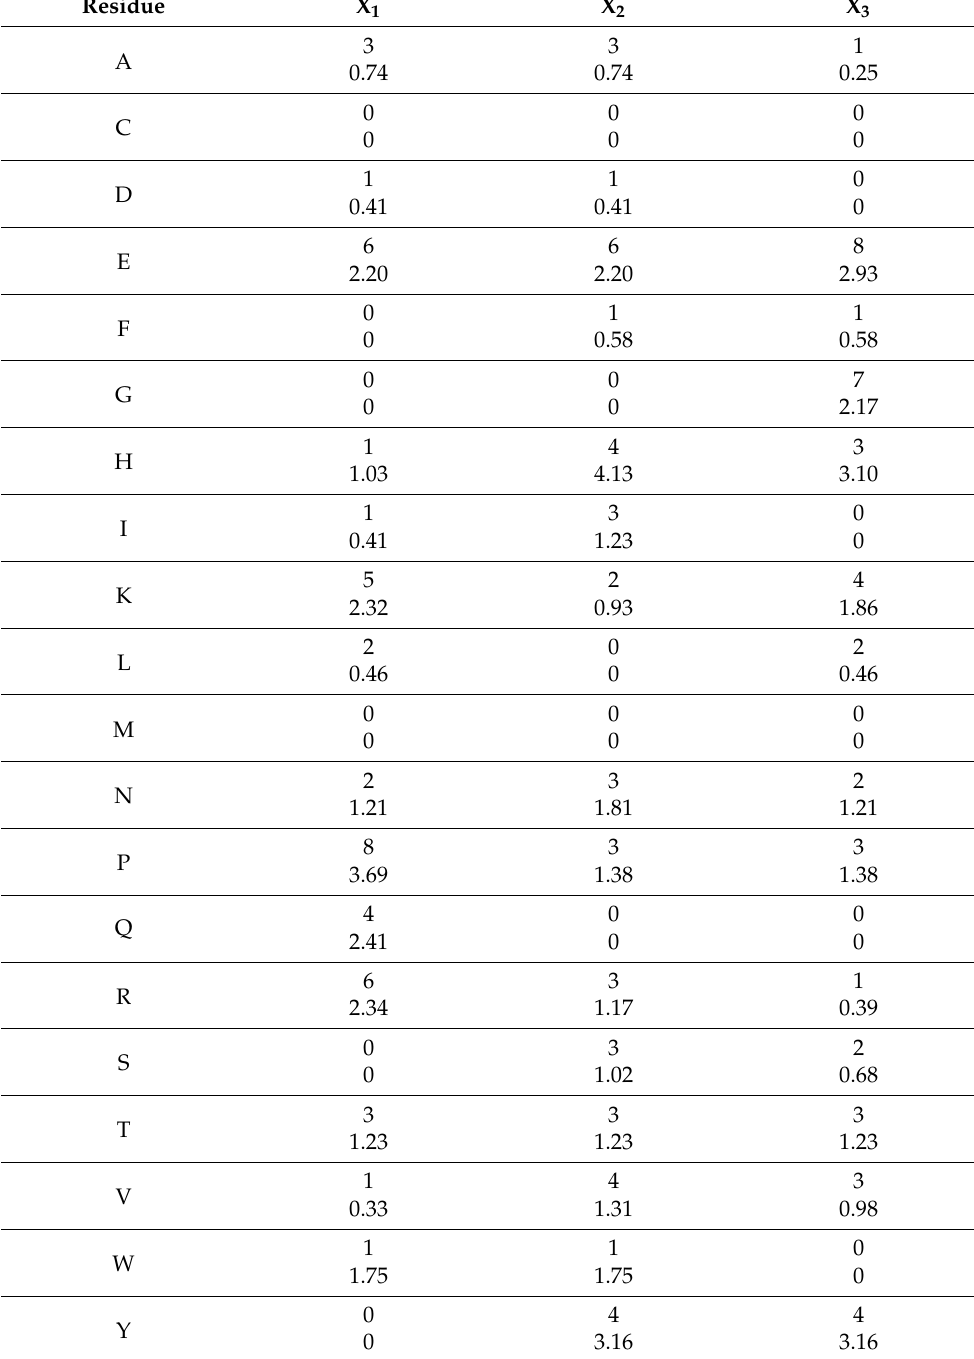
Table 3. Occurrences (first line) and propensities a (second line) for the proteogenic amino acids from the non-redundant -C-X1-X2-H-X3- structural